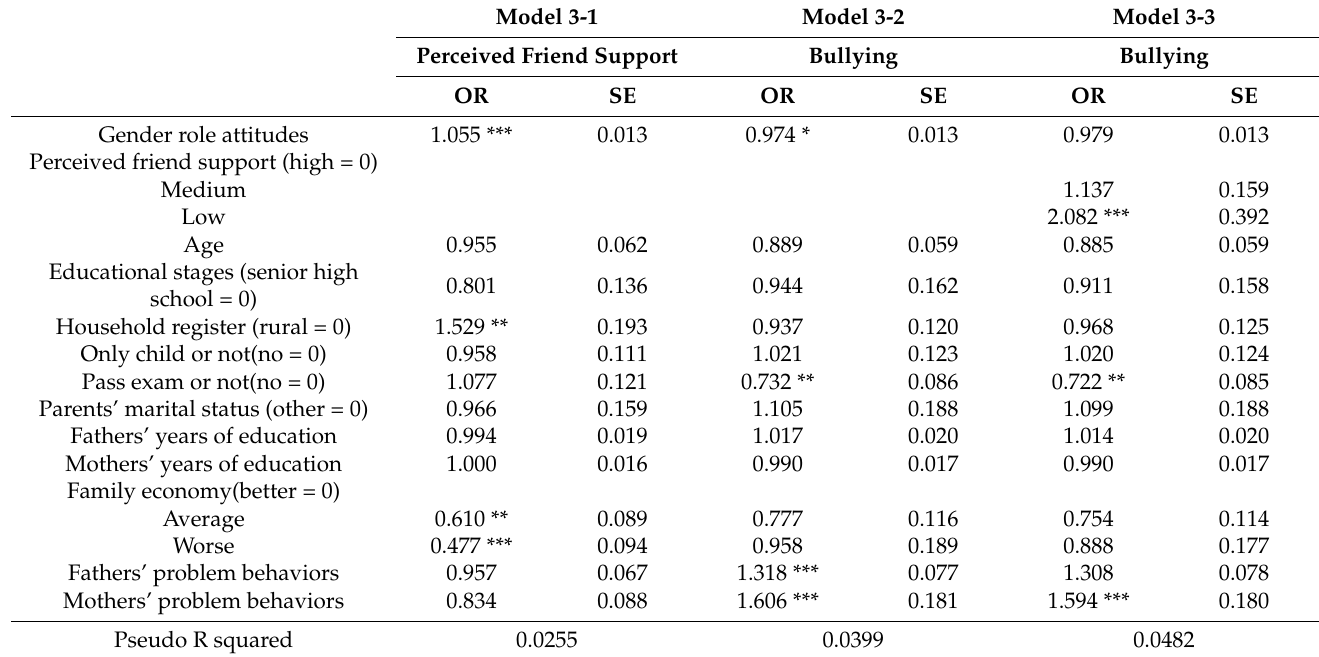
Table 3. Binary logistic regression and ordinal logistic regression predicting bullying and friend support for male students ( n =